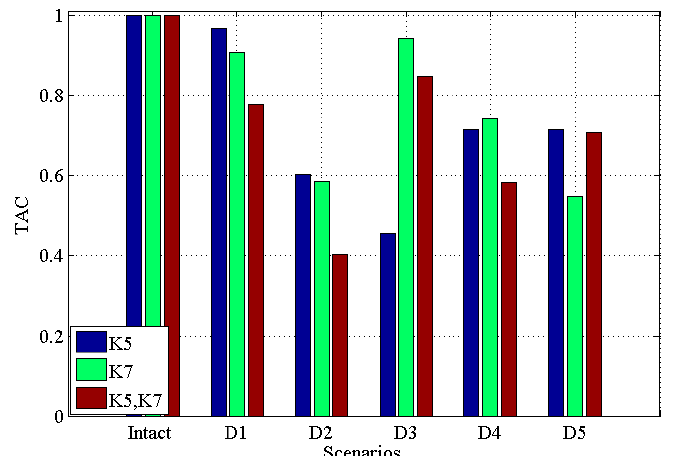
Figure 8. TAC for five damaged scenarios with intact scenario with 5% noise for single damage in K5, single damage in K7, multiple damages in K5 and K7, respectively.